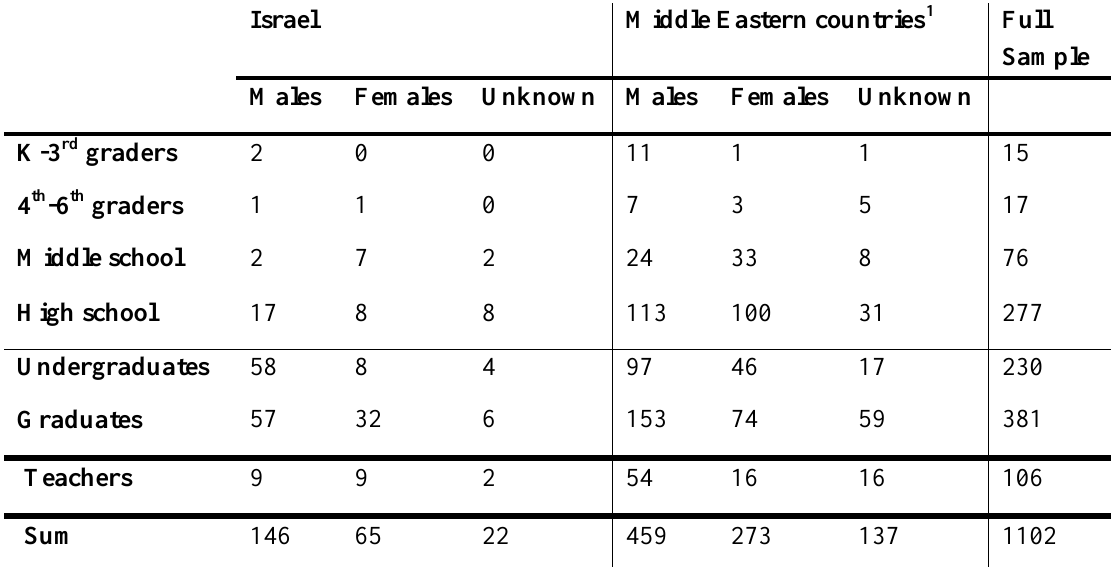
Demographic Characteristics of the Sample Israel Middle Eastern countries 1 Full Males Females Unknown Males Females